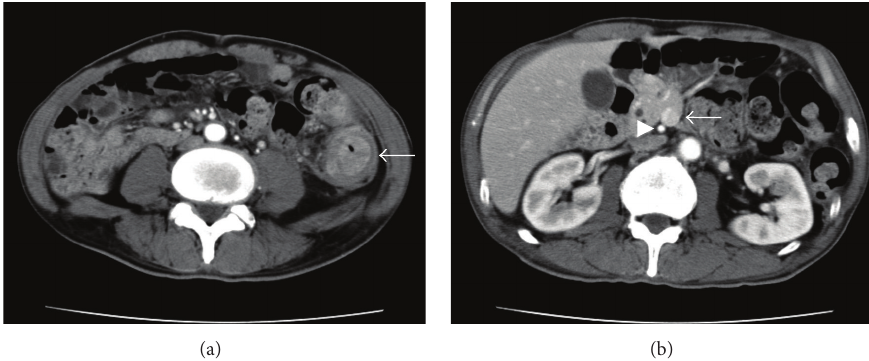
Figure 3: Computed tomography (CT) of the abdomen revealed thickening of the descending colon wall, which was indicative of advanced descending colon cancer (arrow) (a); superior mesenteric vein rotation was also observed (arrow) (b).